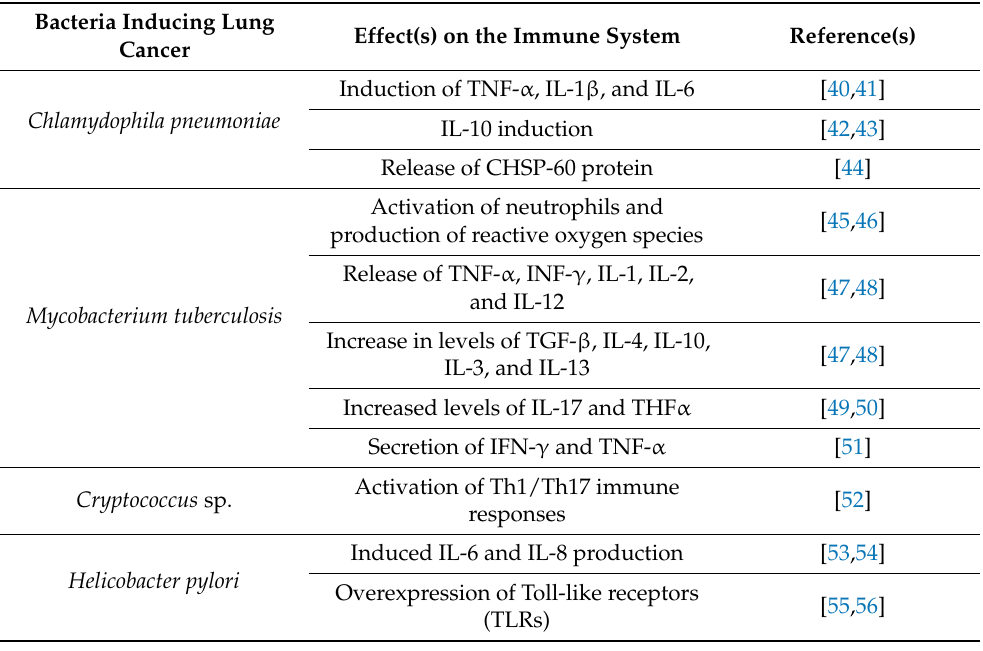
Table 1. Immune mechanisms involved in lung cancer development by various bacterial